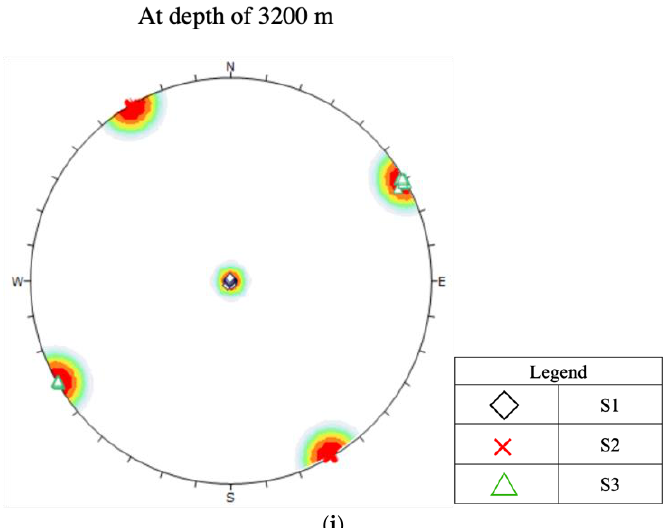
Figure 10. Stereographical projection of induced principal stress directions with tectonic stresses in the study area at depth of ( a ) 0 m; ( b ) 400 m; ( c ) 800 m; ( d ) 1200 m; ( e ) 1600 m; ( f ) 2000 m; ( g ) 2400 m; ( h ) 2800 m; ( i ) 3200 m.